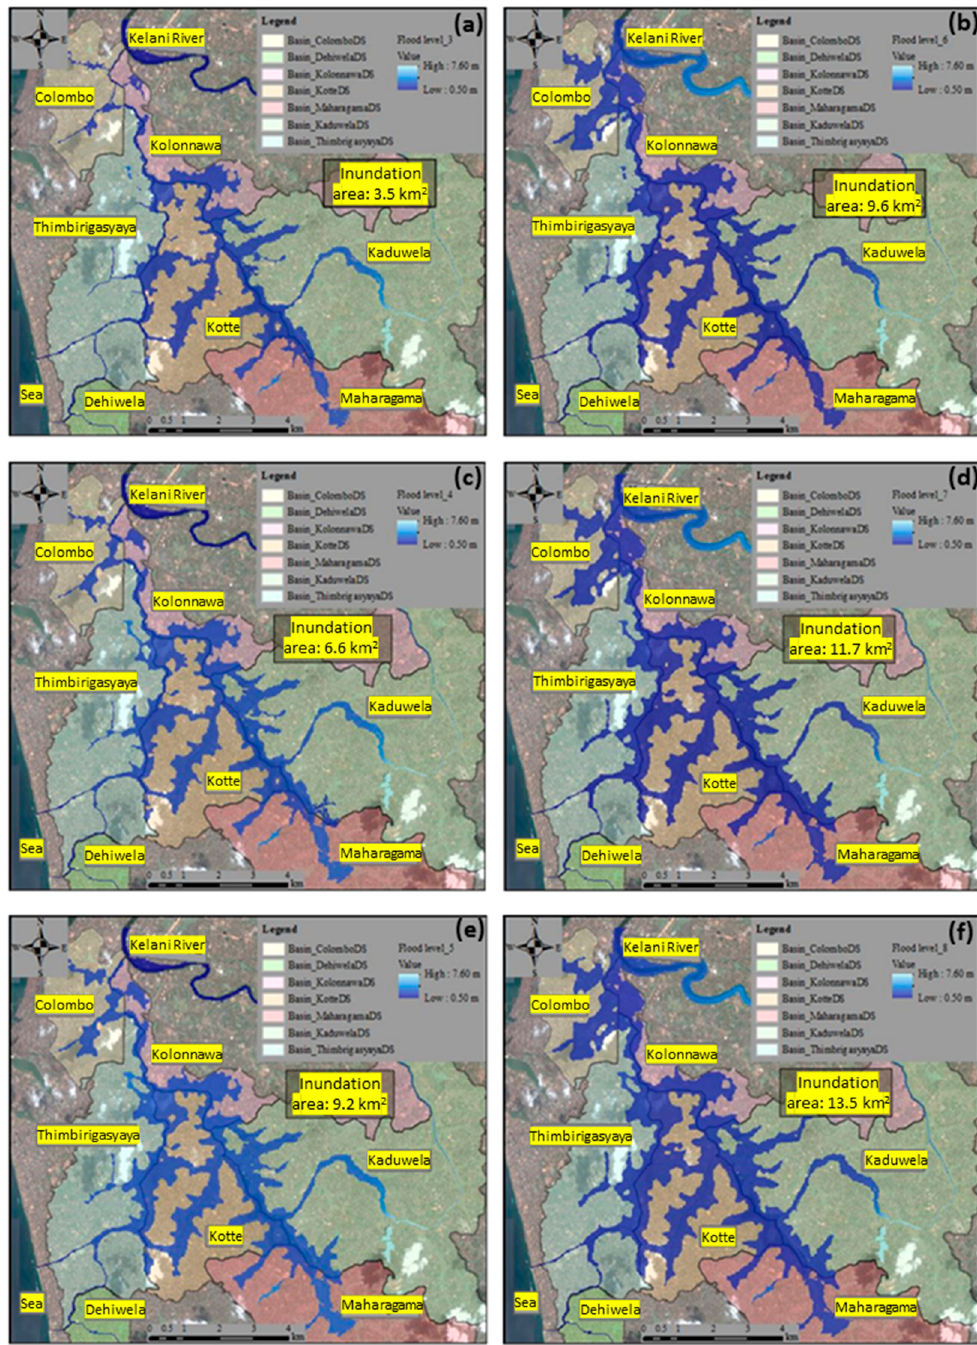
Figure 11. Inundation maps for different scenarios: ( a ) 10-year rainfall with favourable condition; ( b ) 10-year rainfall with least favorable condition; ( c ) 25-year rainfall with favourable condition; ( d ) 25-year rainfall with least favorable condition; ( e ) 50-year rainfall with favourable condition; ( f ) 50-year rainfall with least favorable condition.